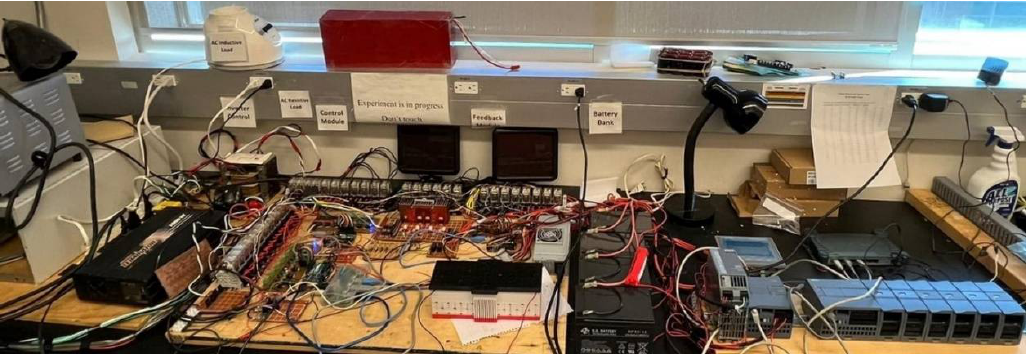
Figure 8. Microgrid experimental setup.